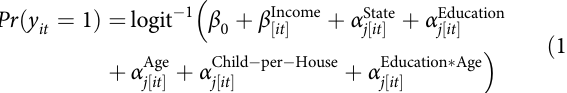
Table 2 National ILI accuracy (horizon = 1 week) scores based on percent CDC ILI visits.